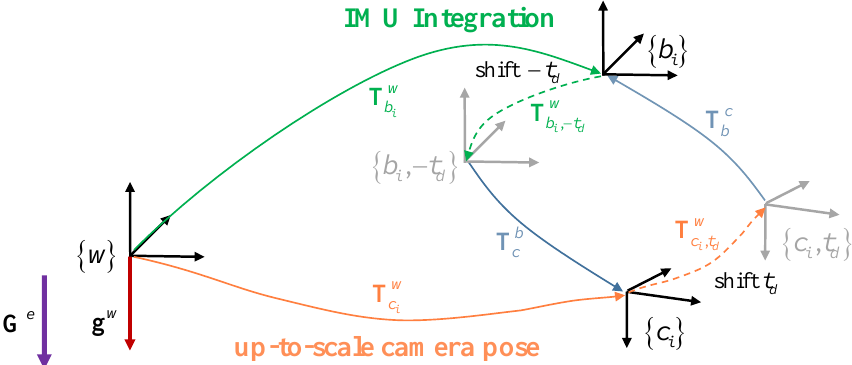
Figure 3. Transformation relationships between the camera and IMU coordinate frames when considering the time offset. The camera and IMU poses can be aligned by shifting the camera pose with t d offset or shifting the IMU pose with − t d offset. The world reference frame { w } coincides with the first keyframe’s coordinate system of the monocular visual odometry front-end. G e is the gravity expressed in the earth inertial reference frame { e }